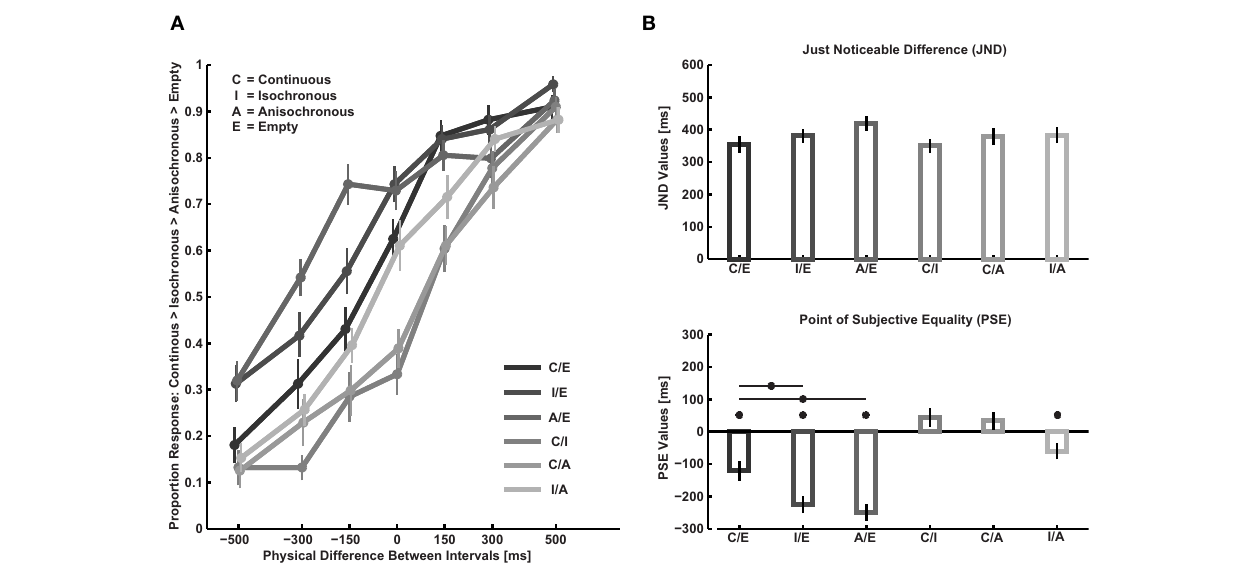
FIGURE 2 | Results of Experiment 2. (A) Proportions of judging continuous > isochronous > anisochronous > empty as a function of duration difference between standard and comparison. (B) Point of subjective equality (PSE) and just noticeable difference (JND) calculated